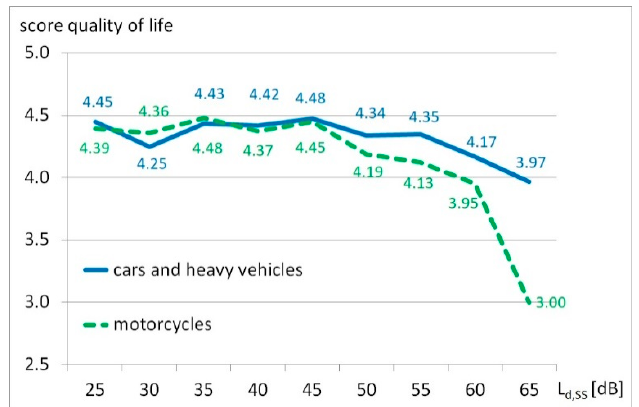
Table 6. Univariate correlation of highly annoyed from 2 ‐ wheelers and 4 ‐ wheelers with other characteristics.